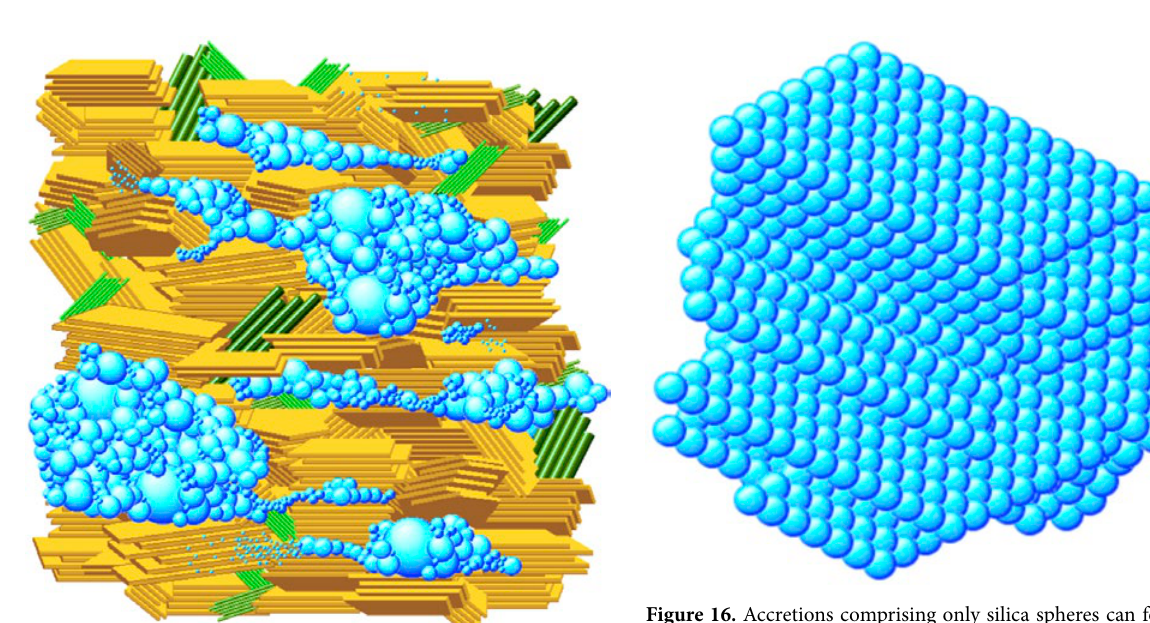
Figure 16. Accretions comprising only silica spheres can form den- se ‘close packed’ aggregates. In this configuration each silica sphere is densely packed in contact with twelve others such that the accre- tion has sufficient internal cohesion to survive in the shear regime (From Elliston 9 , 2017, p.101).